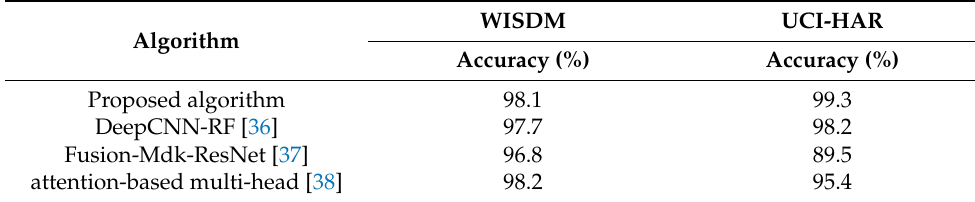
Table 4. Comparison of previous algorithms and proposed